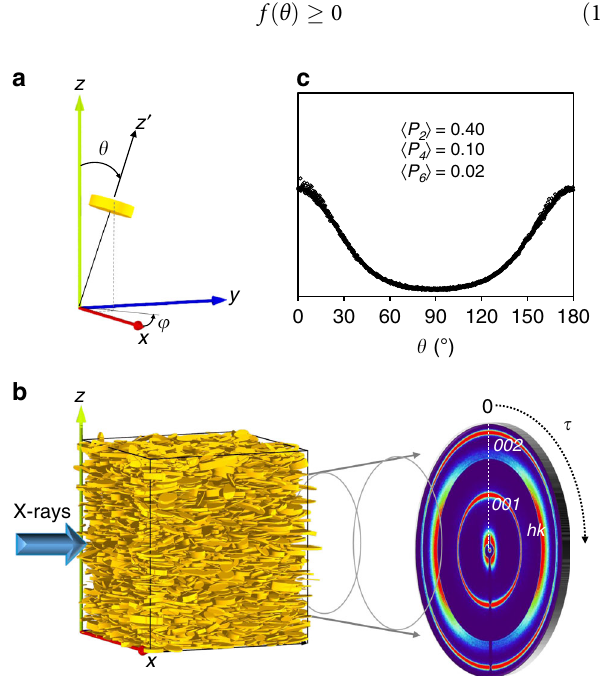
Fig. 1 Experimental measurement of the orientation distribution function. a Spherical coordinates ( θ , φ ) de fi ning the orientation of an individual clay platelet (in yellow) with respect to the laboratory frame. b Schematic representation of an X-ray scattering experiment. The sample is studied in transmission, and scattered intensities are recorded on a planar detector where the color scale ranges from dark blue for the smallest intensity values to red for the largest values. The image here corresponds to a kaolinite sample. The rings corresponding to 00l Bragg re fl ections and hk re fl ections (i.e., 02 and 11 re fl ections) have maximum intensities along the vertical z direction and the horizontal x direction, respectively. c A typical experimental ODF deduced from the angular scan of the 001 diffraction ring using Eq. (4), with the calculated 〈 P 2 〉 , 〈 P 4 〉 , and 〈 P 6 〉 order parameter values from Eq.